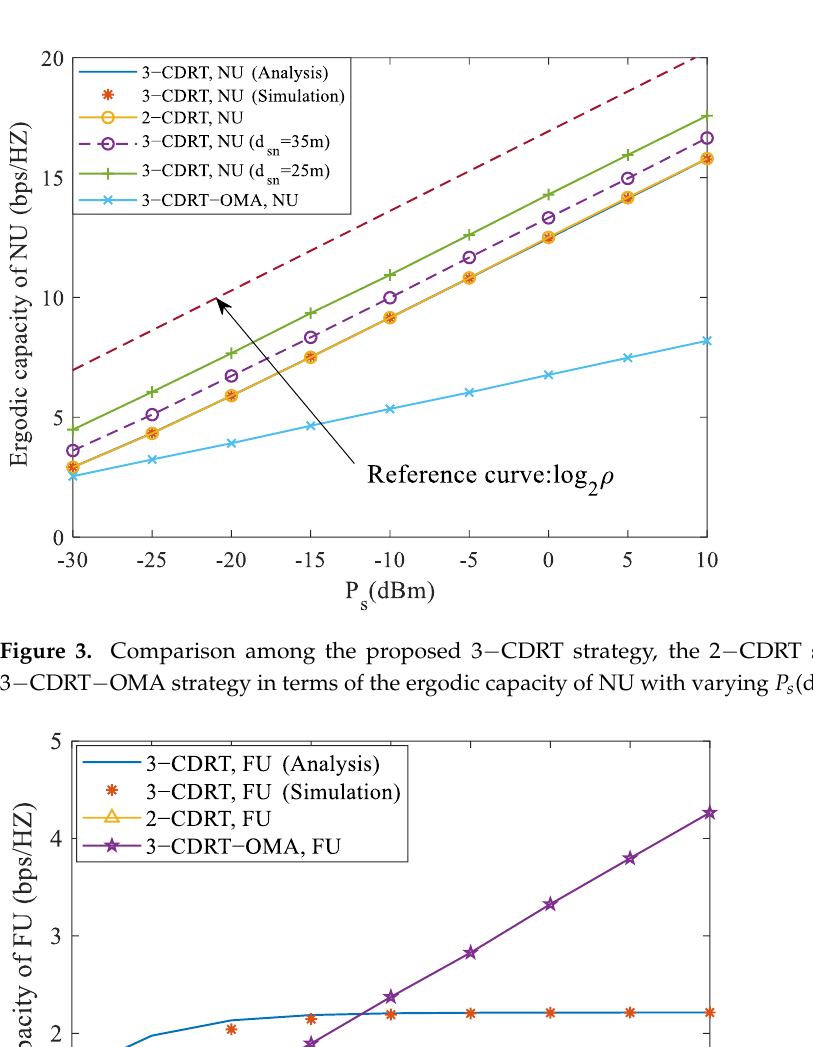
P . In medium and high s